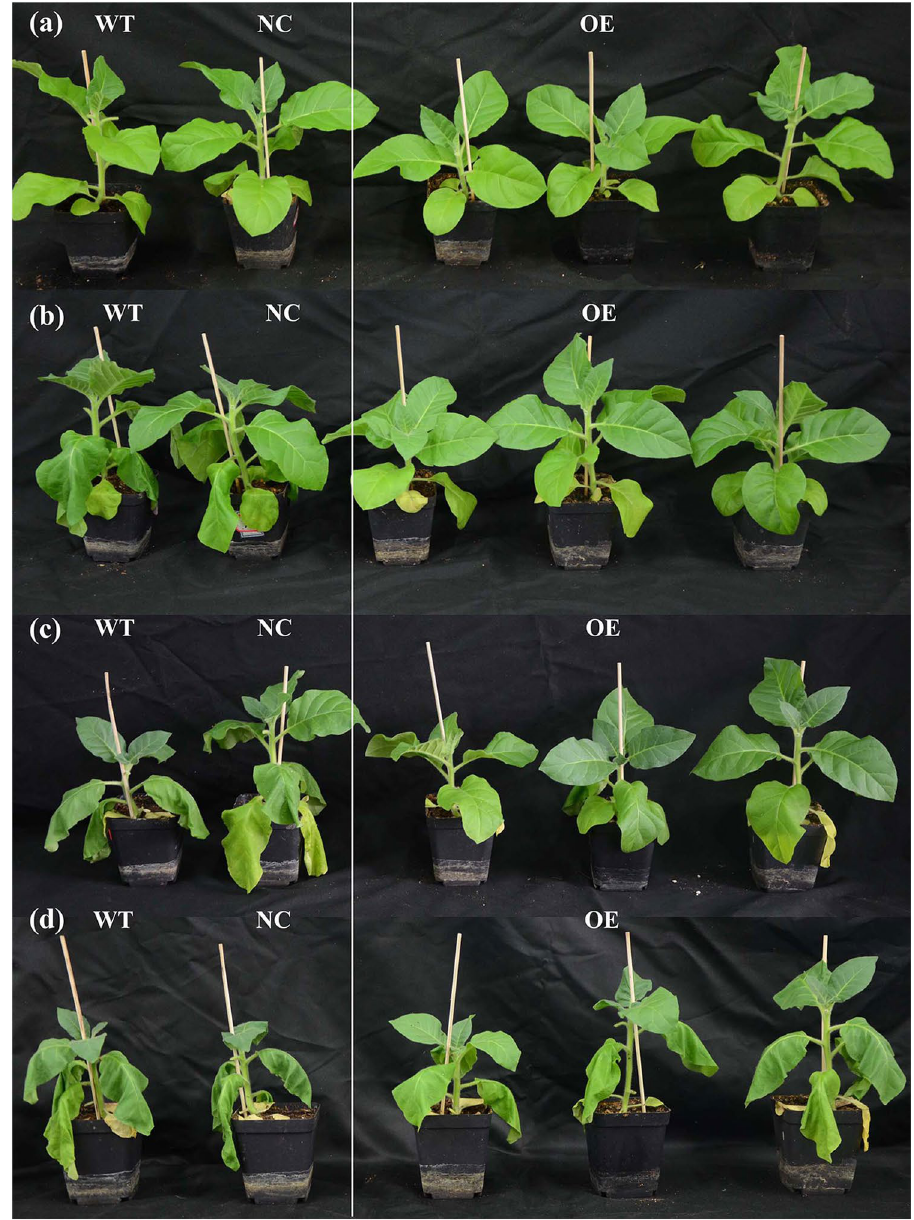
Figure 4. Different phenotypes in 35S::N41 (OE), wild type (WT) and NC (negative control) tobacco plants under increasing drought stress levels. ( a ) Plants with non-treatment; ( b ) plants under light drought (soil water content: 8–10%); ( c ) plants under medium drought (soil water content: 3–5%); ( d ) NC, OE and WT plants under severe drought (soil water content: <